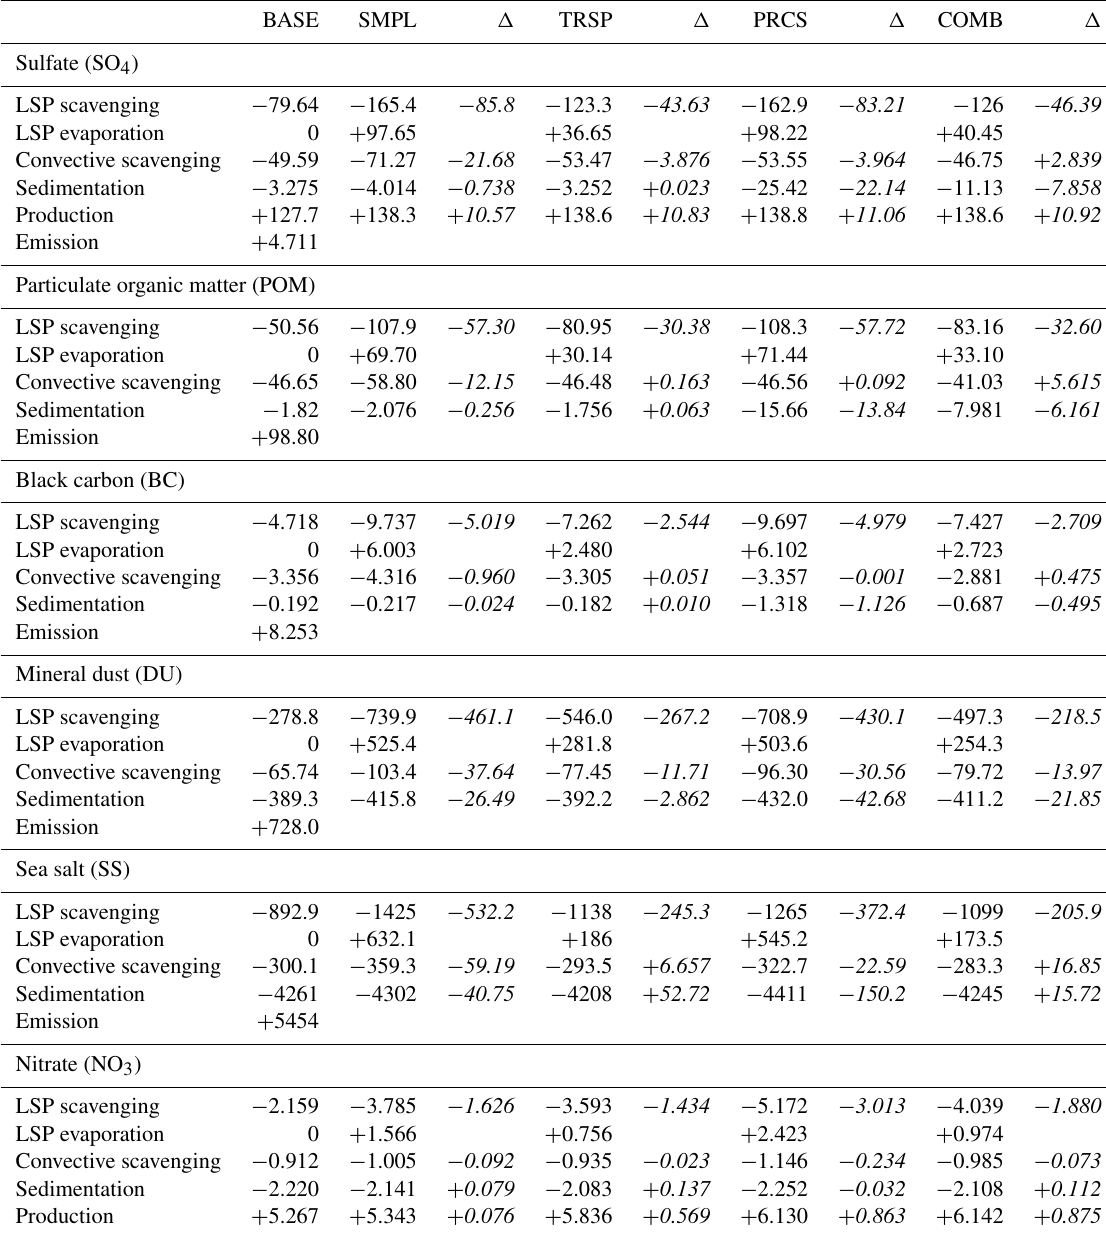
Table B1. Overview of global total annual change (Tgyr − 1 ) due to individual (removal) processes for all aerosol species. Positive numbers indicate a source, whereas negative number indicate a removal process. The change with respect to the BASE simulation is denoted in italic